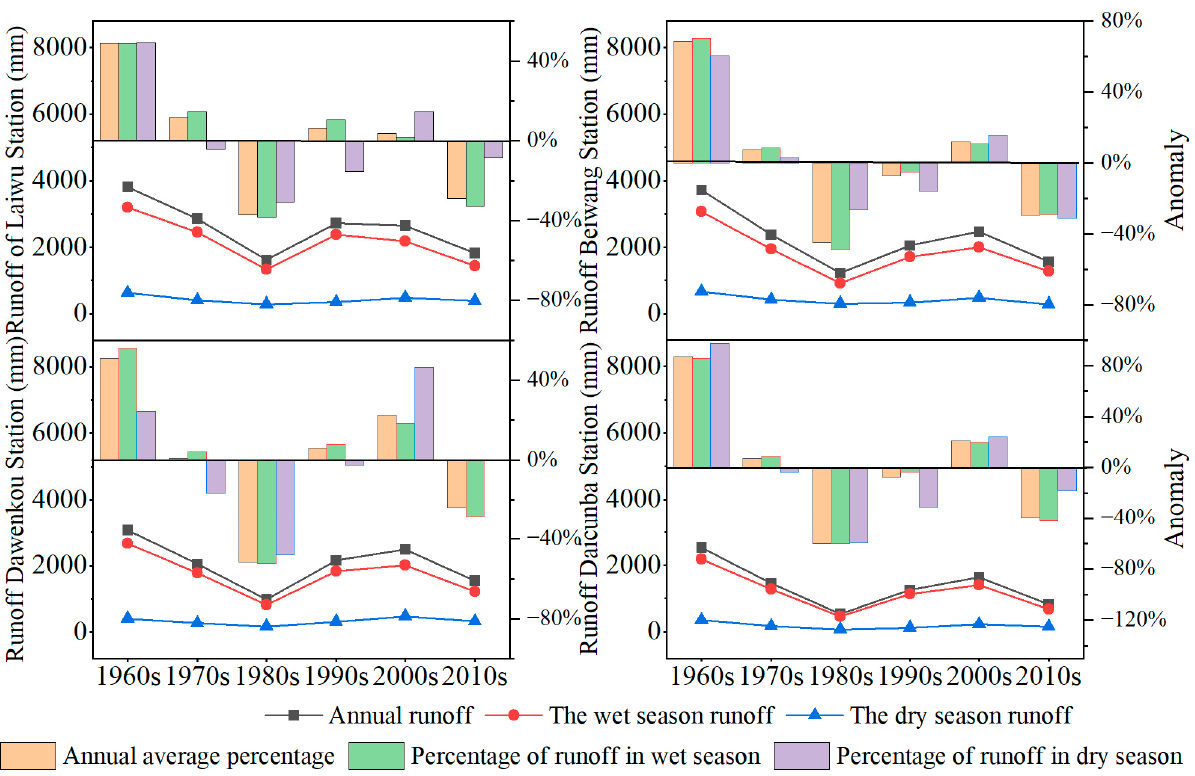
Figure 5. The decadal runoff anomaly map of the Dawen River